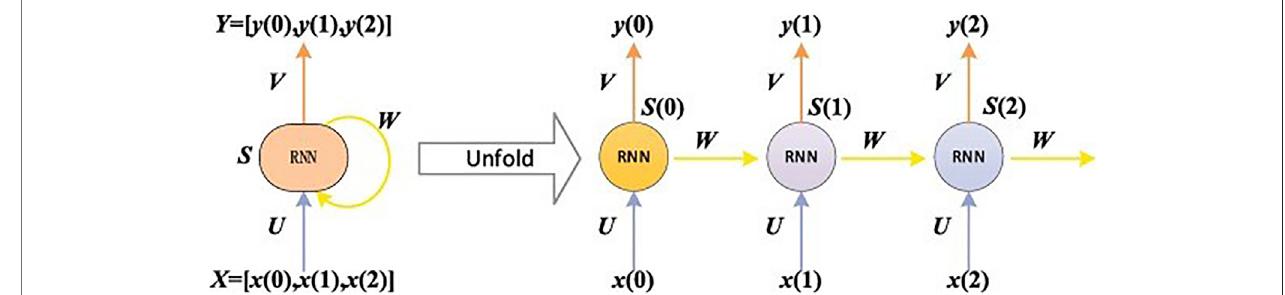
FIGURE 1 | The structure of recursive neural network (RNN) (Wang et al., 2020).